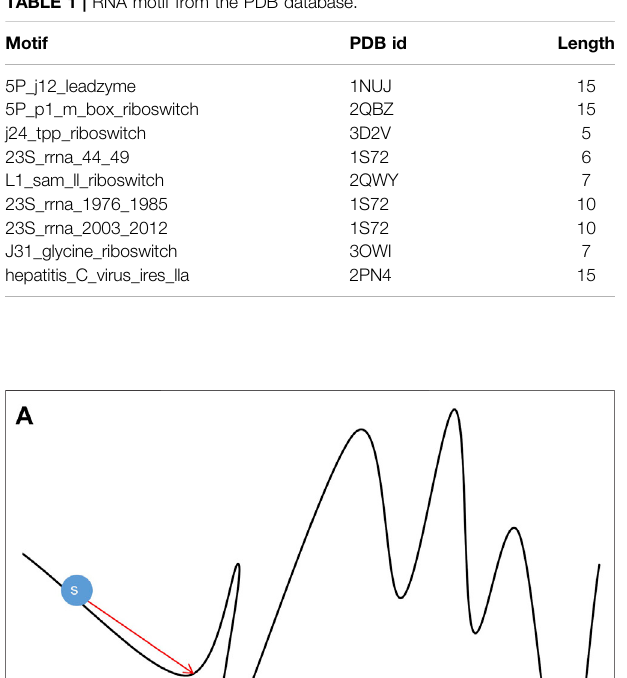
Frontiers in Genetics |